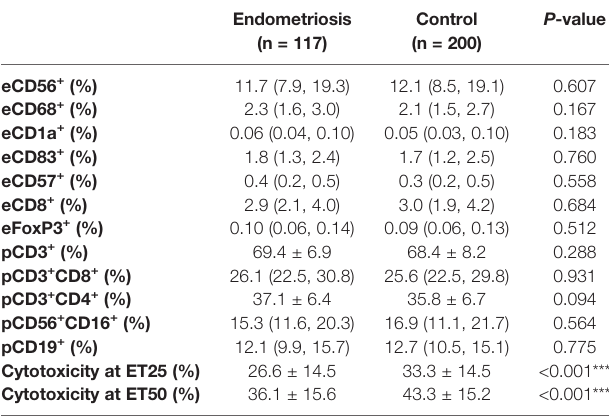
TABLE 2 | Comparison of lymphocyte subsets from endometrium or peripheral blood and cytotoxicity of peripheral NK cells between females with or without a history of